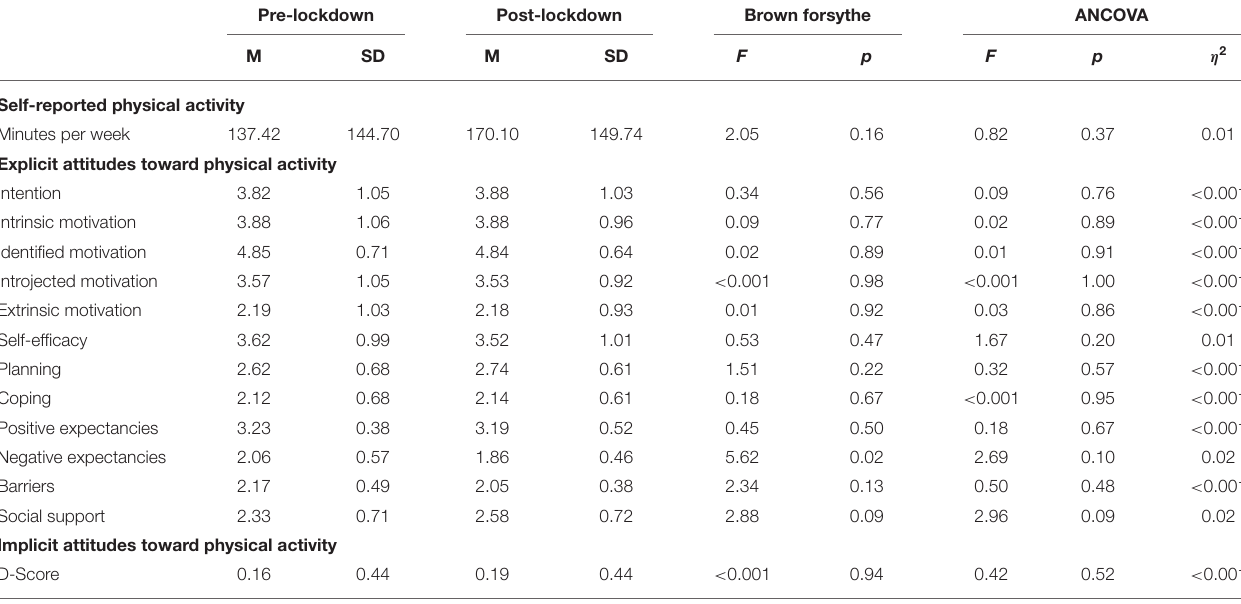
TABLE 3 | Between-group differences in self-reported physical activity and explicit and implicit attitudes toward physical activity.